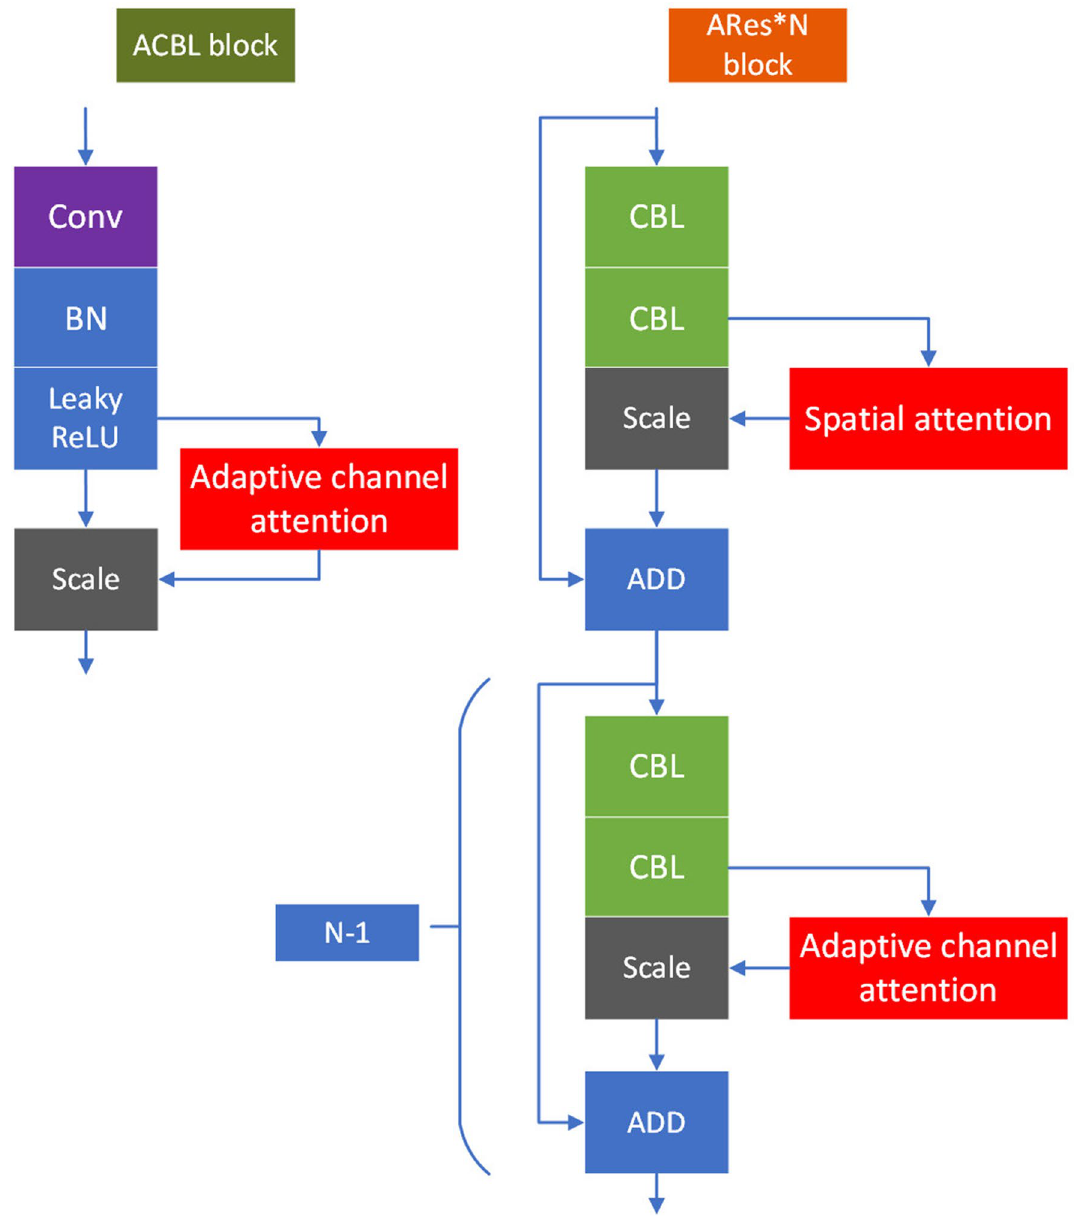
Figure 5. Detailed intro-block connections of ‘ACBL’ and